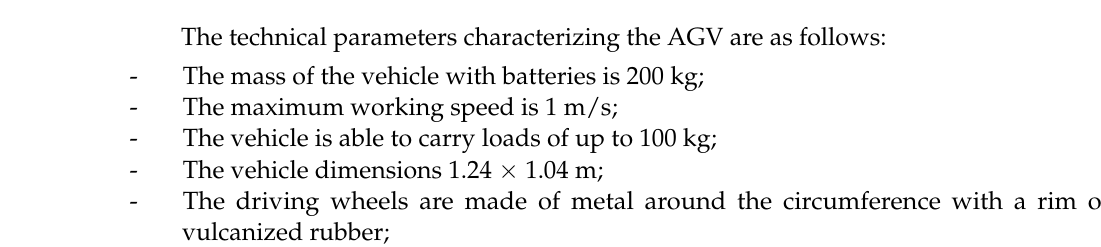
Figure 2. The automated guided vehicle that is the subject of this research: ( a ) rear view of the vehicle; ( b ) front view of the vehicle.